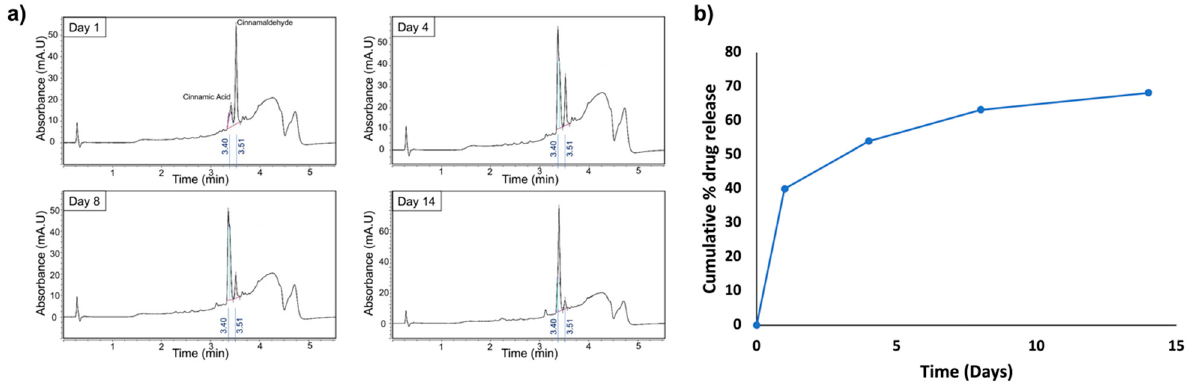
Figure 3. HPLC analysis of trans -cinnamaldehyde release over time. ( a ) Analysis of supernatants with representative chromatograms after one, four, eight, and fourteen days. The peak at 3.40 min and 3.51 min correspond to cinnamic acid and trans -cinnamaldehyde respectively. Trans -cinnamaldehyde release is maximal after one day, and decreases over time, with a slight release still visible after 14 days. ( b ) Cumulative drug release pattern of pSi-TC NPs, depicting that pSi-TC NPs able to deliver TC over a 14-day period of sustained release manner.